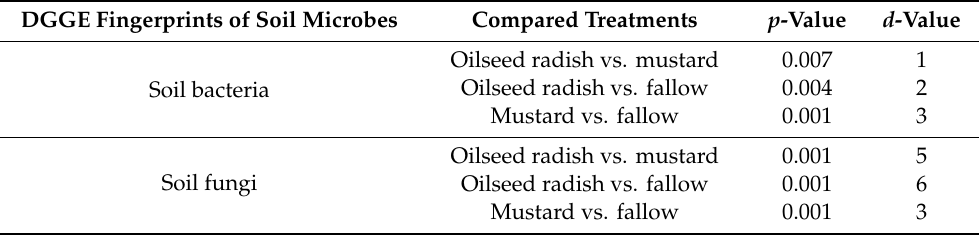
Table 2. P- and d -value resulting from the permutation tests to compare the average similarities of 16S rRNA and ITS gene profiles derived respectively from the DGGE fingerprints of the soil bacteria and fungi at the Gross Munzel location ( P - and d- value based on the Pearson correlation similarities).